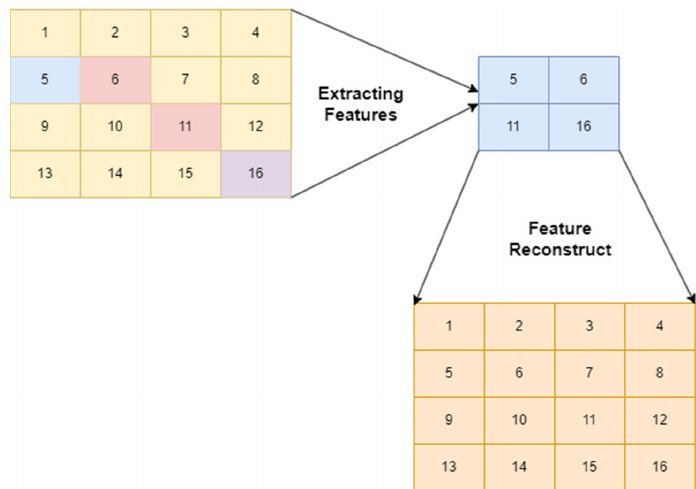
Figure 4. Process of feature extraction.